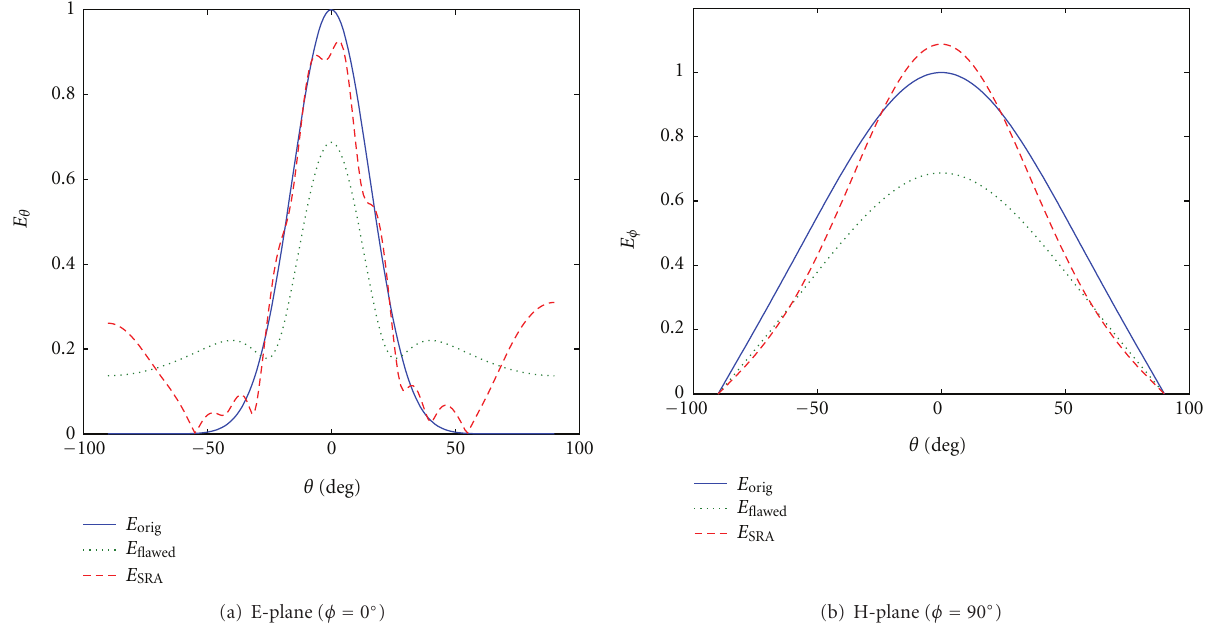
Figure 13: Pattern comparison in E-plane and H-plane of a 1 × 6 linear binomial broadside array of rectangular microstrip antennas placed along x -axis with element #3 flawed.